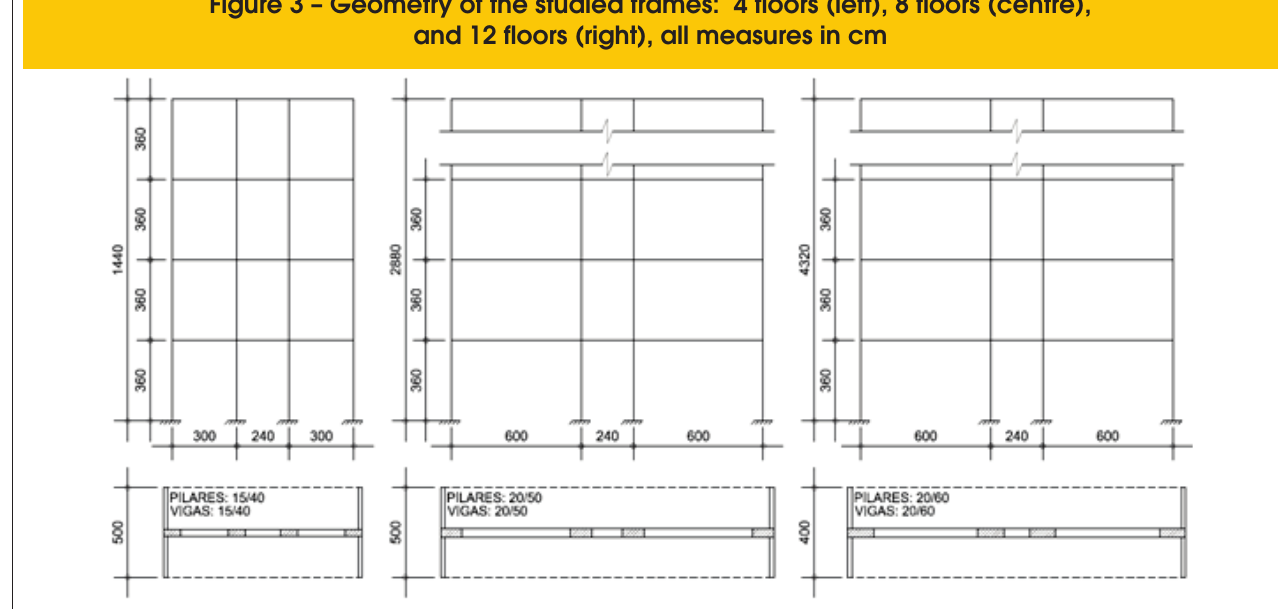
Figure 3 – Geometry of the studied frames: 4 floors (left), 8 floors (centre), and 12 floors (right), all measures in